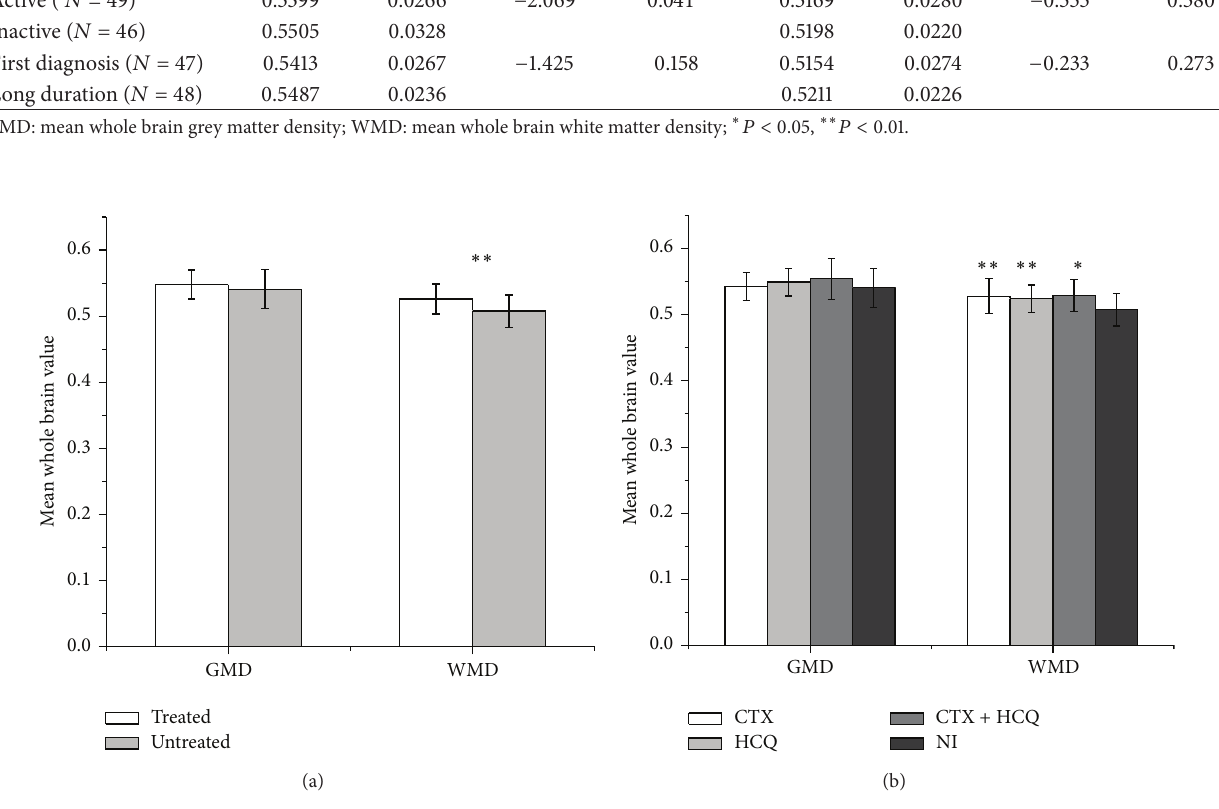
Figure2:GMD/WMDandtherelationshipswithdifferenttreatmentsinSLEpatients.Thepatientsreceivingtreatmentwithimmunosuppres- sive agents had a greater WMD than the patients who were never treated with immunosuppressive agents. There was no significant difference in the GMD between the two groups (a). The CTX-, HCQ-, or CTX+HCQ- treated patients had significantly higher WMDs compared with the NI group. Pairwise-group comparisons showed that the NI patients had the lowest WMD (b). GMD: mean whole brain grey matter density; WMD: mean whole brain white matter density; CTX: cyclophosphamide; HCQ: hydroxychloroquine; NI: nonimmunosuppressive agents treated. ∗ 𝑃 < 0.05 , ∗∗ 𝑃 < 0.01